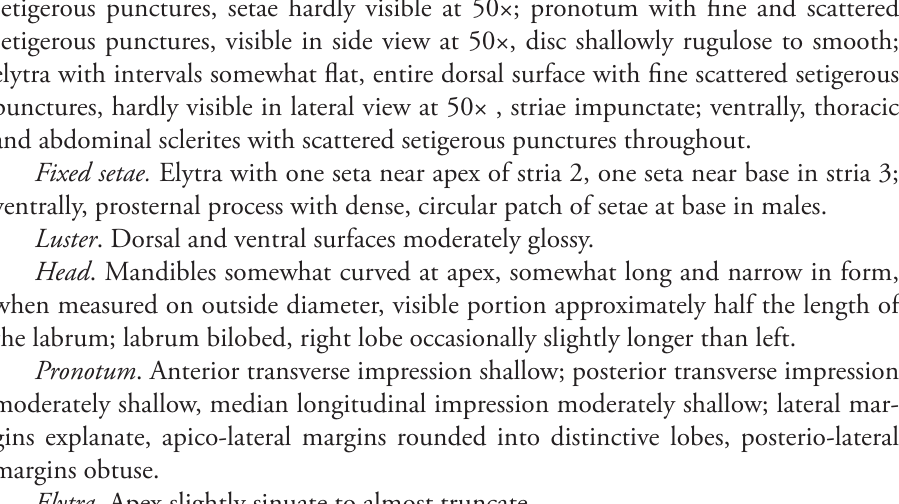
ventral surface of head, smooth with microsculpture not visible at 50×. Prosternum, proepipleuron, mesepisternum and metepisternum with sculpticells forming a shallow, somewhat transverse to transverse